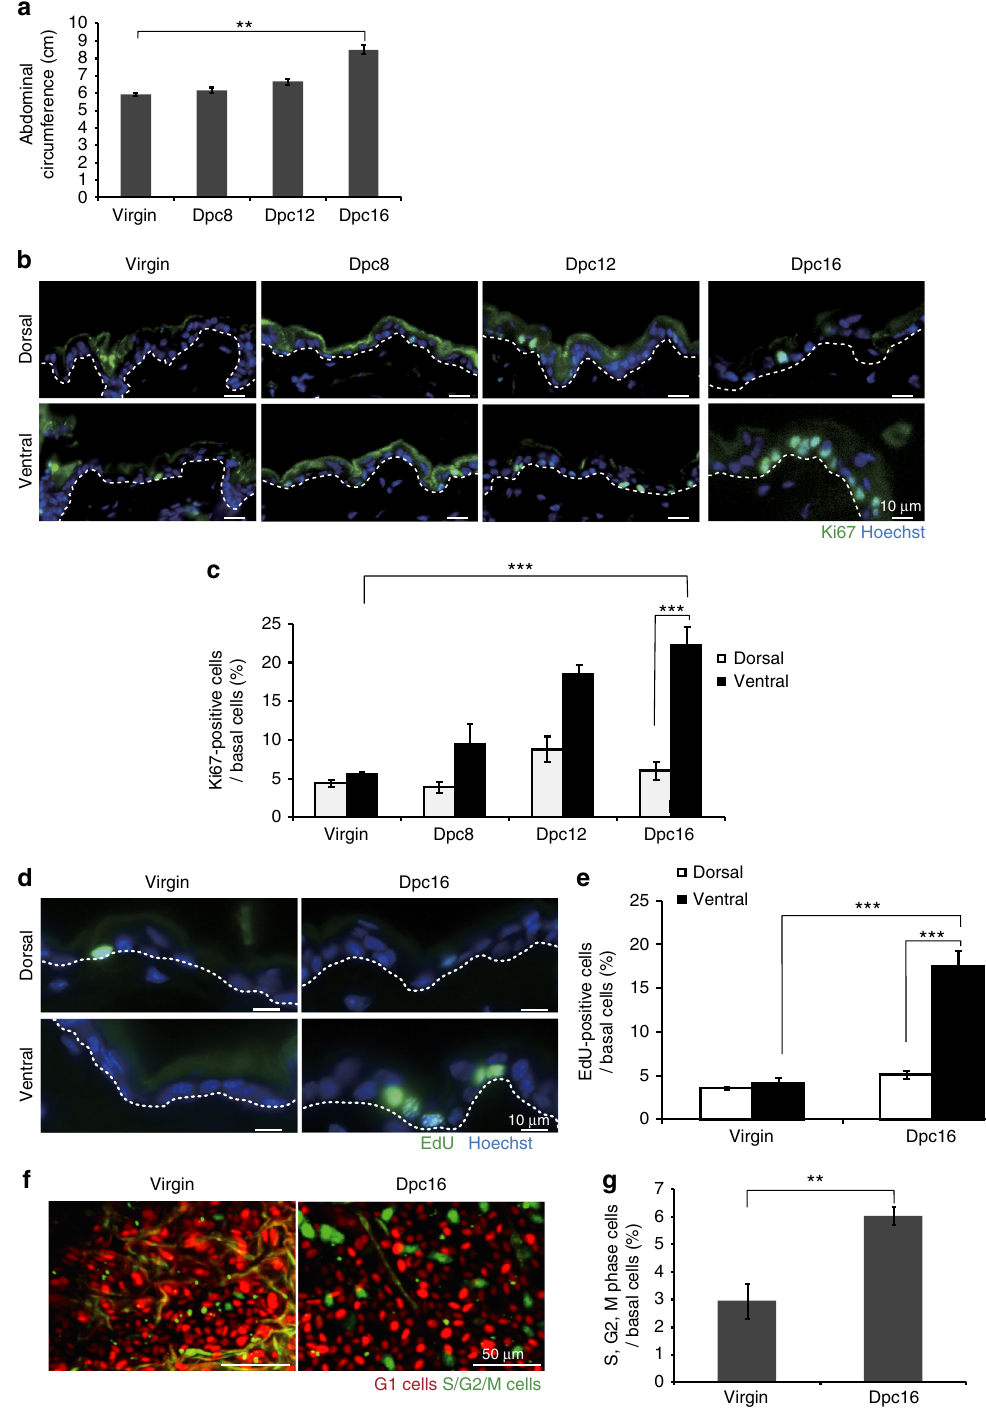
Fig. 1 IFE basal cells in the abdominal skin of pregnant mice are highly proliferative. a Abdominal circumferences of virgin and pregnant (8 – 16 dpc) mice. Data represent the mean ± standard error of the mean ( s.e.m .) ( n = 3 mice); ** P < 0.01, analysed by the two-tailed t -test. b Immuno fl uoresence of Ki67 ( green ) and Hoechst ( blue ) on dorsal ( upper ) and ventral ( bottom ) skin from virgin and pregnant (8 – 16 dpc) mice. c Quanti fi cation of Ki67 + cells in IFE basal layers. d Immuno fl uoresence of EdU ( green ) and Hoechst ( blue ) on dorsal ( upper ) and ventral ( bottom ) skin from virgin and 16 dpc mice. e Quanti fi cation of EdU + cells in IFE basal layers. f Two-photon microscopic images of ventral skin in Fucci2 virgin and 16 dpc mice, where cells in G1 and S/G2/M phases exhibit red or green fl uorescence, respectively. g Quanti fi cation of cells in S/G2/M phases in ventral skin IFE of Fucci2 mice. Data represent the mean ± s.e. m. of averages of seven sections ( n = 7) pooled from three mice. More than 700 cells were analysed to calculate the average in each section; ** P < 0.01, analysed by the two-tailed t -test. c , e Data represent the mean ± s.e.m. of averages of three independent experiments ( n = 3). More than 500 cells were analysed to calculate the average in each experiment; ** P < 0.01, *** P < 0.001, analysed by Dunnett ’ s multiple comparison test. b , d White-dotted lines indicate basement membranes. Experiments were repeated three times with three mice for representative images in ( b , d , f